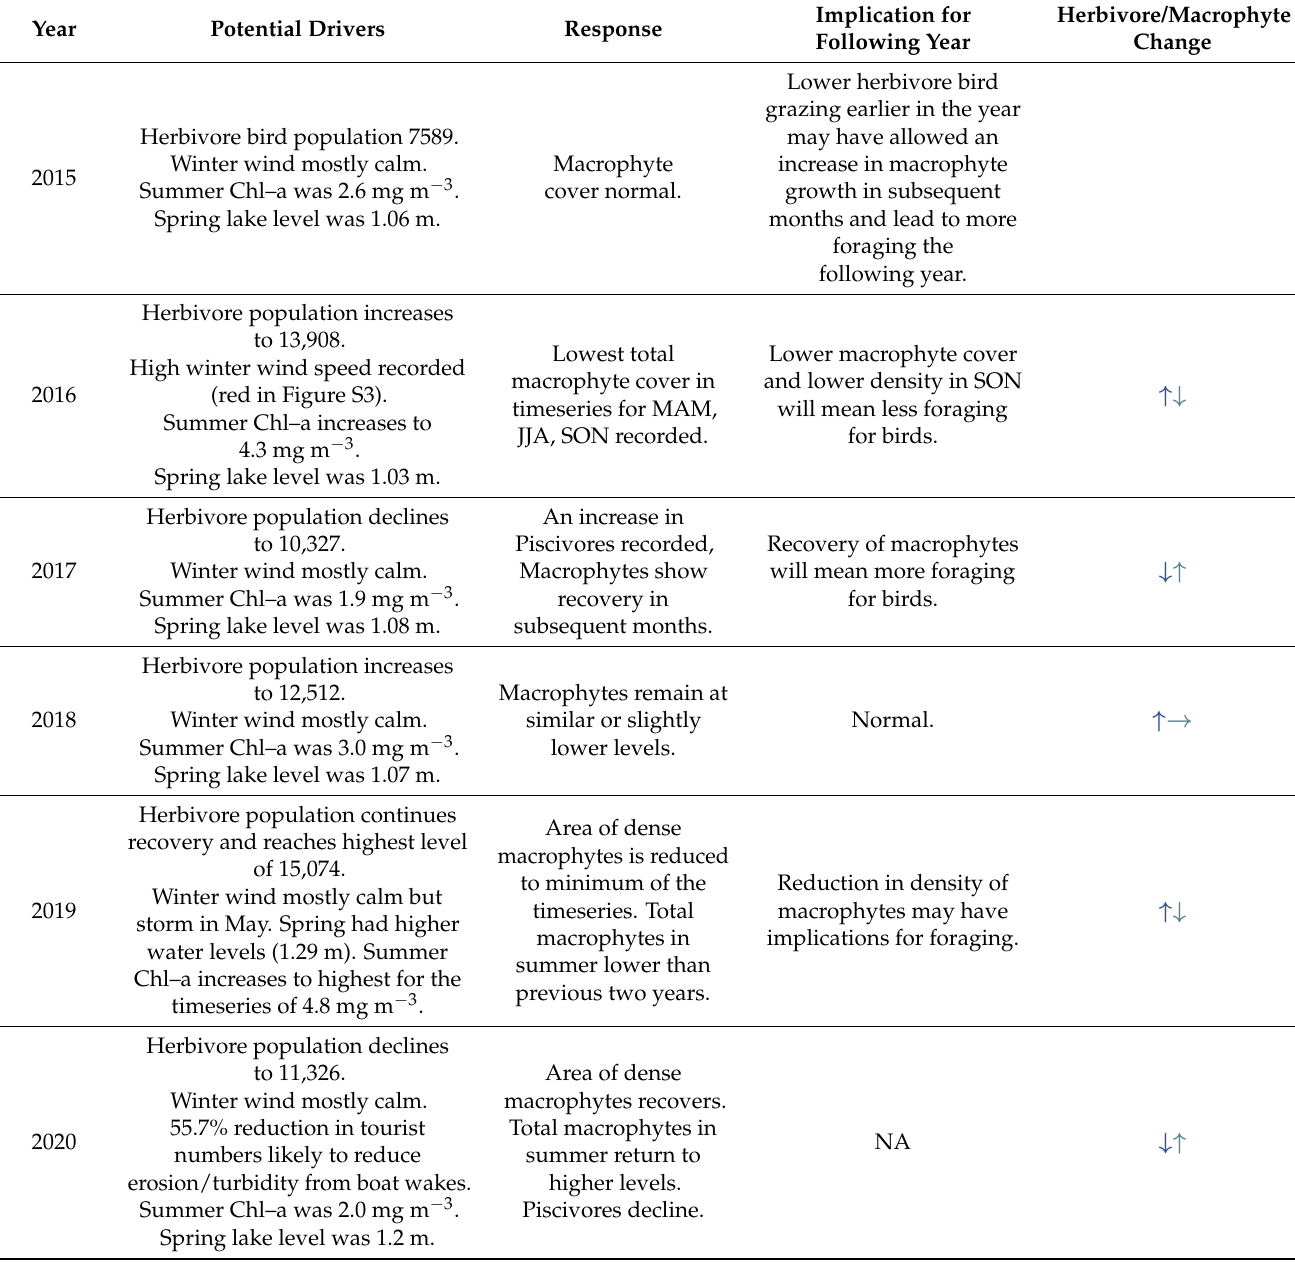
Table 5. Potential drivers, responses, and implications of changes in macrophyte cover in Lake Garda from 2015 to 2020 (MAM = March, April, May; JJA = June, July, August; SON = September, October, November). Upward/downward/sideways arrows indicate increase/decrease/stable trend in herbivores (blue) or macrophytes